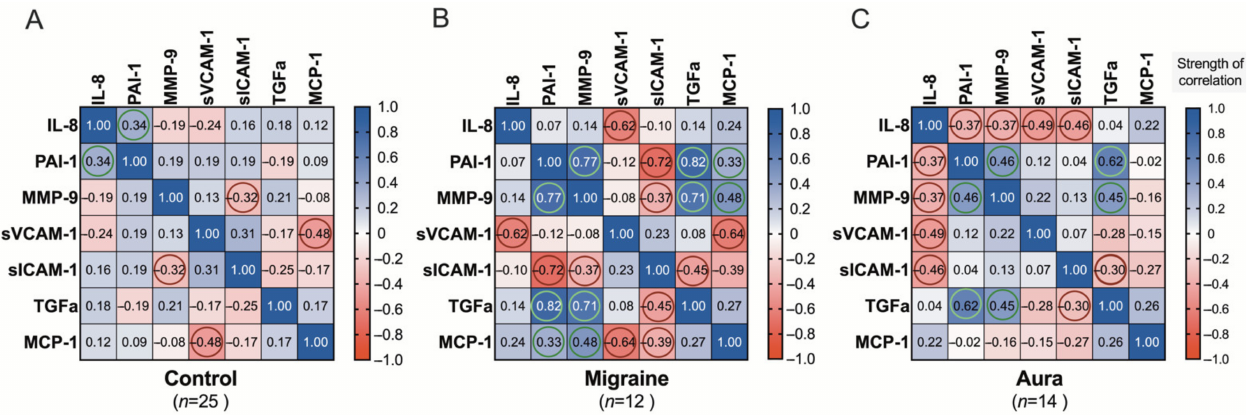
Figure 5. Spearman’s rank correlation ( r S ) matrix showing the interrelationships of the studied cytokines: ( A ) associations in healthy individuals (control); ( B ) associations in migraine patients without aura; ( C ) associations in migraine patients with aura. More pronounced associations are marked with colour